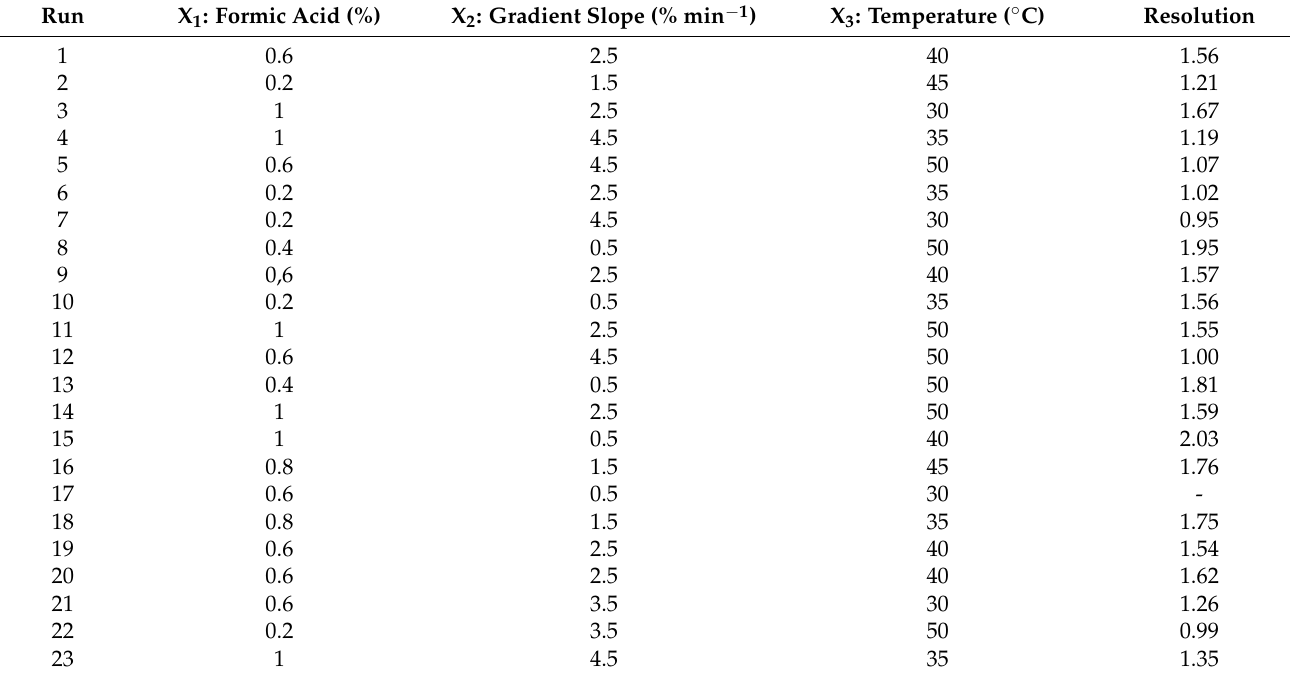
Table 1. Influence and response factors of the experimental design for intermediate purification by